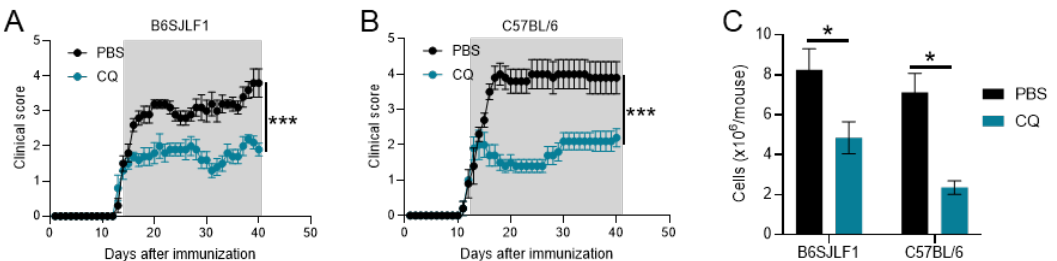
Figure 1. Chloroquie (CQ) suppresses neuroinflammation in two models of experimental autoimmune encephalomyelitis (EAE). C57BL/6 and B6SJLF1 mice ( n = 5/group) were immunized to induce EAE. At the onset and until the end of experimentation, mice were treated with CQ (5 mg/kg) via i.p. everyday. ( A ) Disease development in B6SJLF1 mice and in ( B ) C57BL/6 mice. ( C ) CNS cells were analyzed at day 21 post-immunization. Values of p < 0.05 (*) and < 0.001 (***) were considered